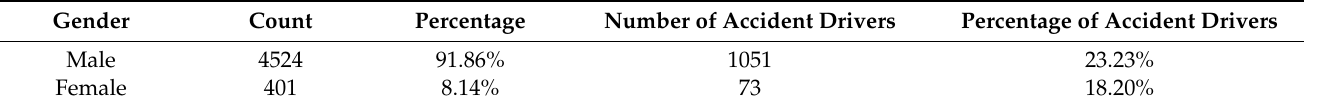
Table 6. Gender distribution.